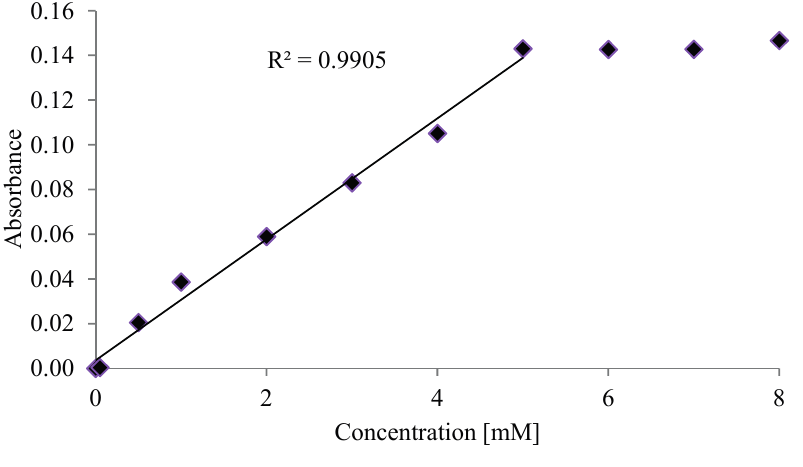
Figure 3. Glucose absorbance calibration curve after 15 min run.